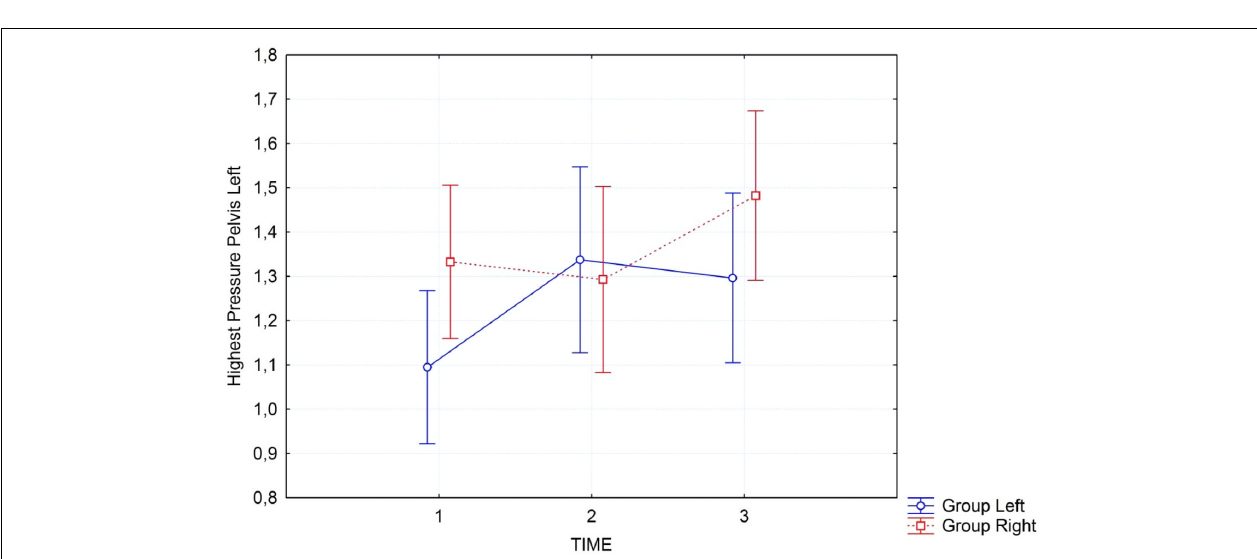
FIGURE 3 | Interaction graph of “highest pressure” in the pelvis region on the right side of the body, for the two groups separately: group left (blue line) started with left side; group right (red line) started with right side. Error bars refer to 95% confidence intervals.